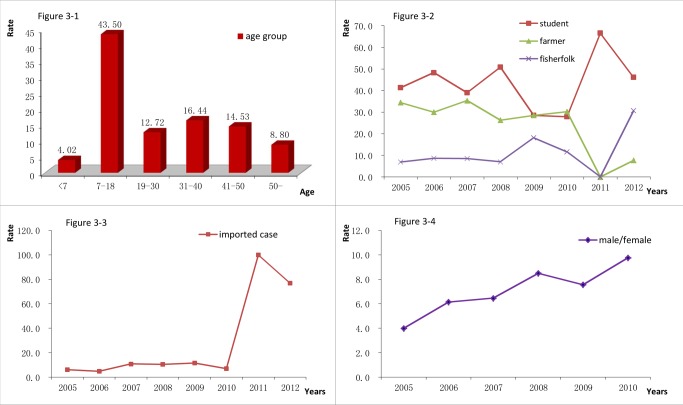
Population distribution of acute schistosomiasis cases from 2005 to 2012 (Figure. 3-1: age distribution, Figure 3-2: occupational distribution, Figure 3-3: annual distribution of imported cases, Figure 3-4: annual ratio of male/female from 2005 to 2010).